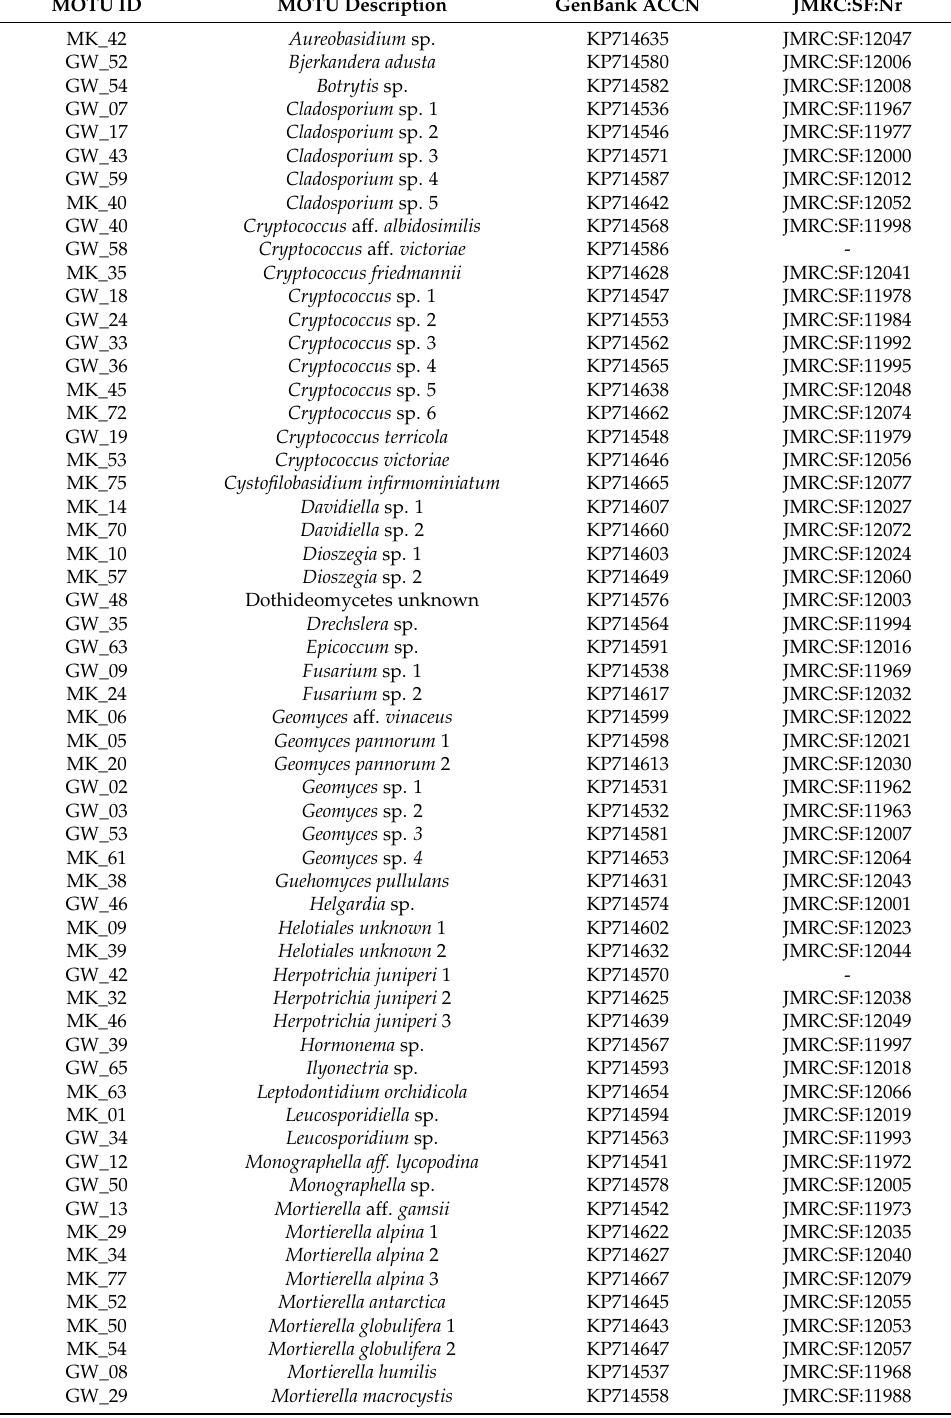
Table A1. List of MOTUs obtained with direct colony PCR from 788 fungal strains. GenBank accession numbers (ACCN) and collection numbers in the Jena Microbial Resource Collection (JMRC:SF:Nr) are provided. MOTUs are sorted alphabetically by